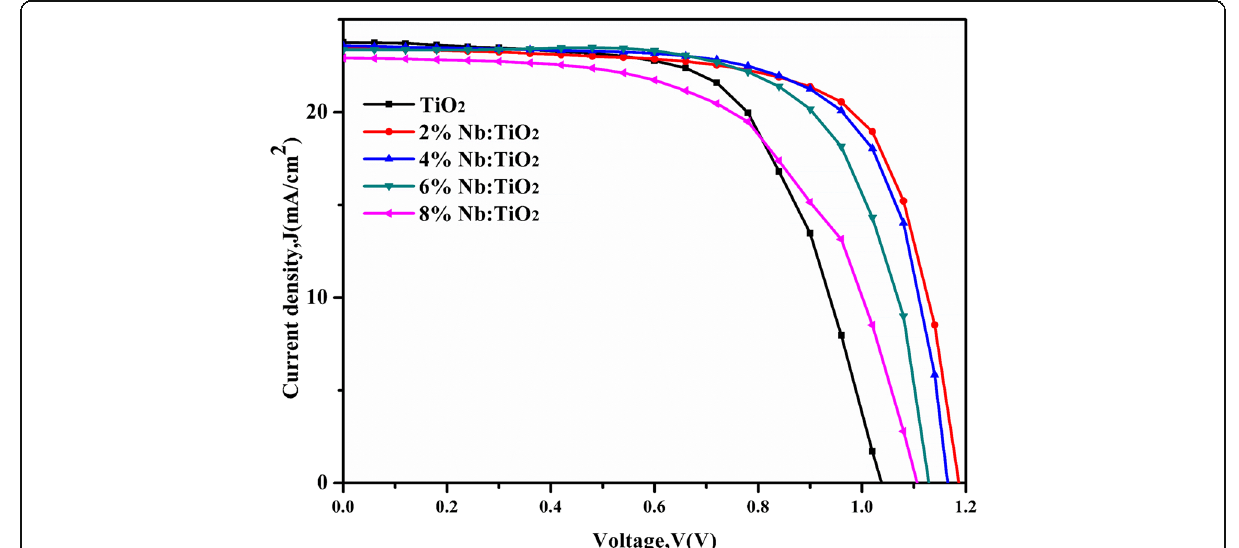
Fig. 6 J-V curves of PSCs based on different Nb doping